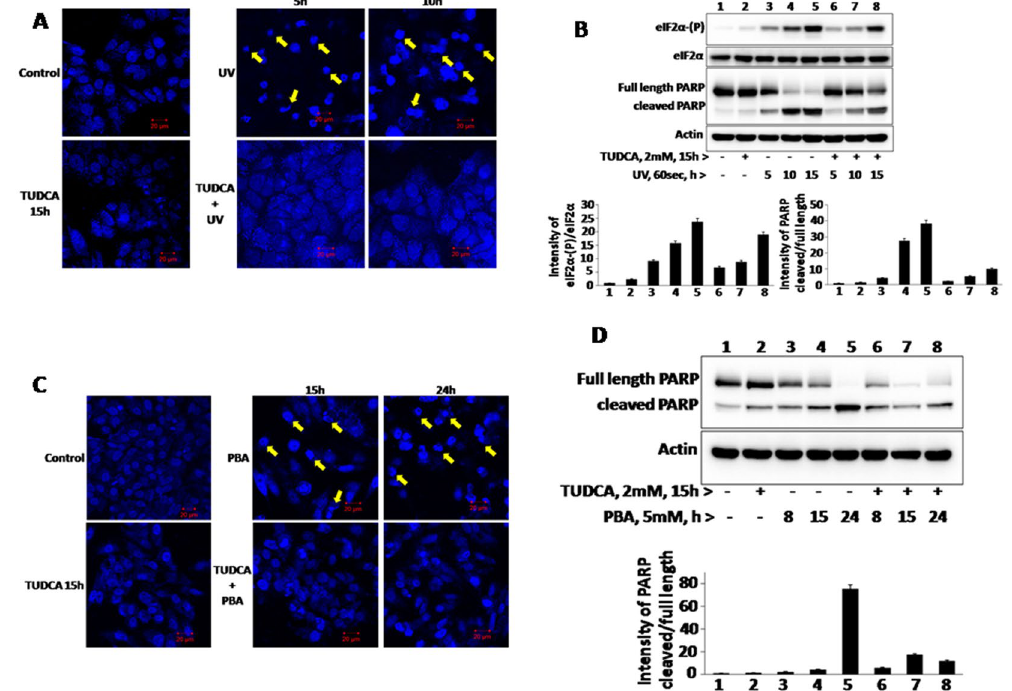
Figure 7. UV-B irradiation or PBA induced nuclear fragmentation and PARP cleavage in the presence of TUDCA: To determine the effect of TUDCA on UV-B irradiation and PBA induced nuclear fragmentation and PARP cleavage, 2 mM TUDCA pretreated cells (15 h) were exposed to UV-B irradiation for 60 seconds (200 J/ m 2 ) or treated with 5 mM PBA and then cells were incubated at 37° C for 5 and 10 h after UV- irradiation, or 15 and 24 h after PBA treatment. Nuclear fragmentation was analyzed by DAPI staining in confocal microscopy (Panel A and Panel C) as described in ‘Materials and Methods’. Arrow marks indicate fragmented nuclei. PARP cleavage was analyzed for respective treatments by a specific antibody by western blotting (Panel B and